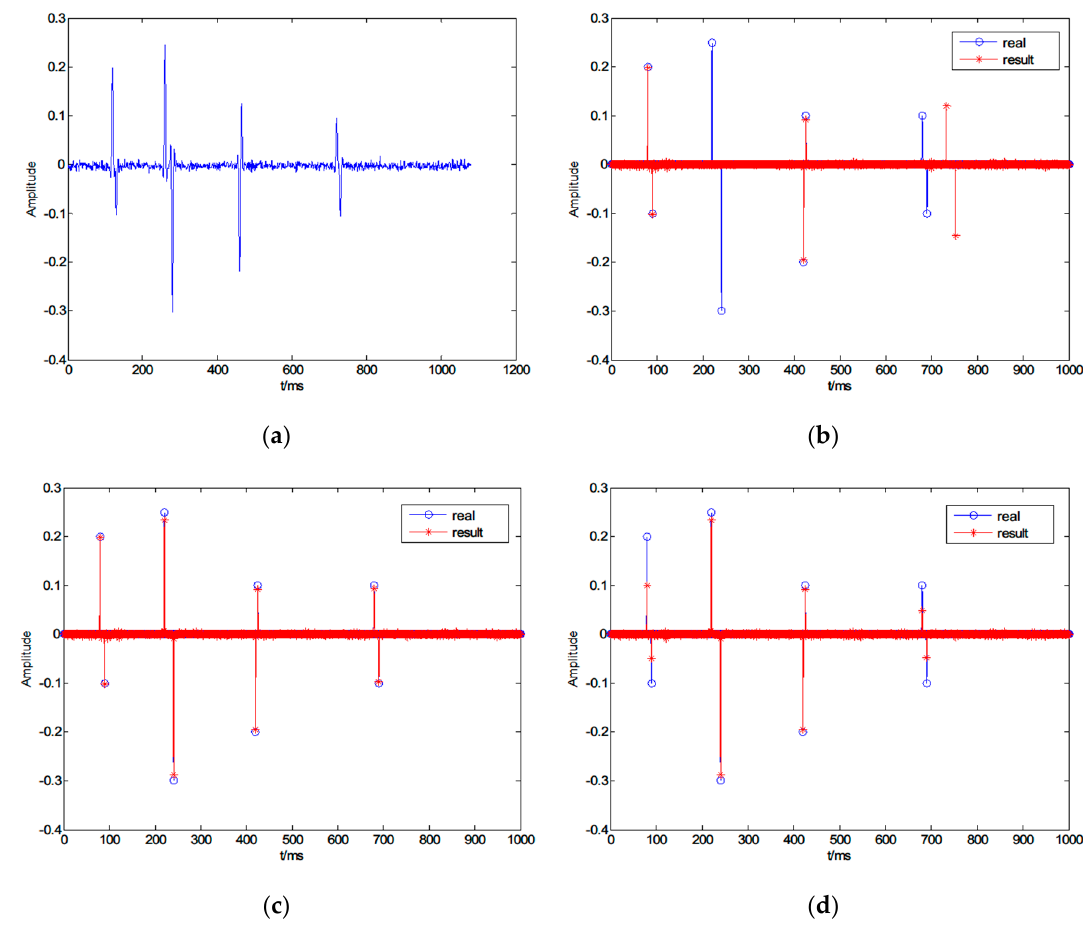
Figure 8. The influence of time window length and sliding step size on inversion results. ( a ) Synthetic seismic trace; ( b ) inversion result when the sliding step size is equal to the time window length; ( c ) inversion result when the sliding step size is equal to 1/2 of the time window length; and ( d ) inversion result when the sliding step size is equal to 1/4 of the time window length.